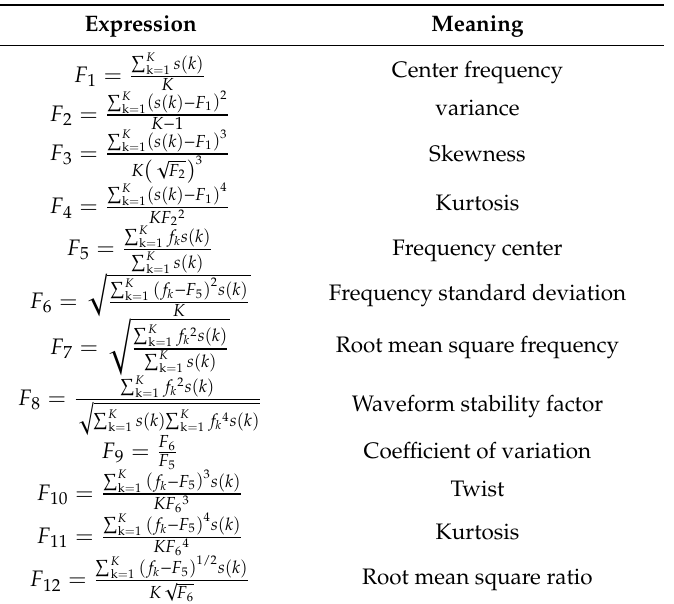
Table 2. Frequency domain feature